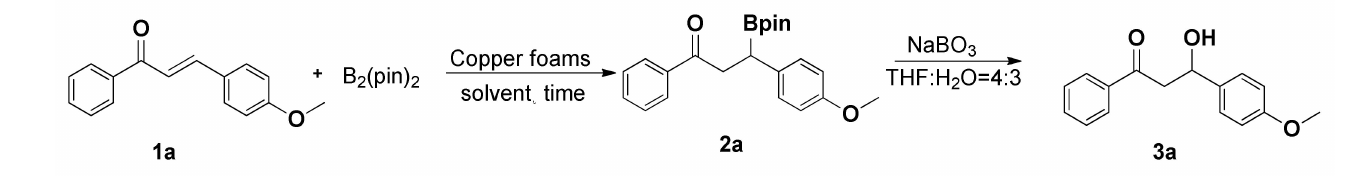
Figure 8. The boron addition reaction general